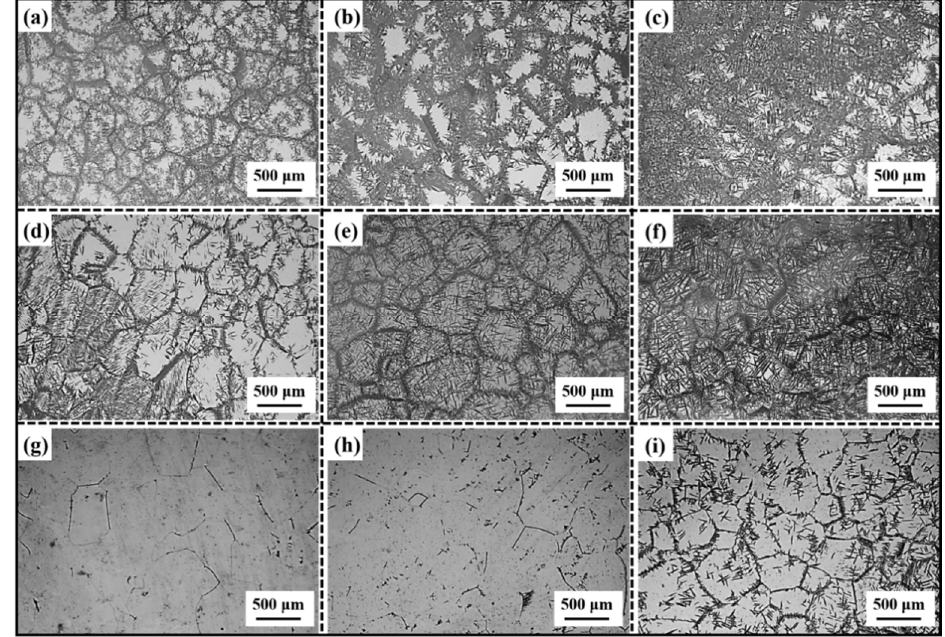
Figure 5. The OM images of the heat-treated Ti-22Al-25Nb alloy at ( a ) 900 °C/1 h, ( b ) 900 °C/1.5 h, ( c ) 900 °C/2 h, ( d ) 930 °C/1 h, ( e ) 930 °C/1.5 h, ( f ) 930 °C/2 h, ( g ) 950 °C/1 h, ( h ) 950 °C/1.5 h, and ( i ) 950 °C/2 h.